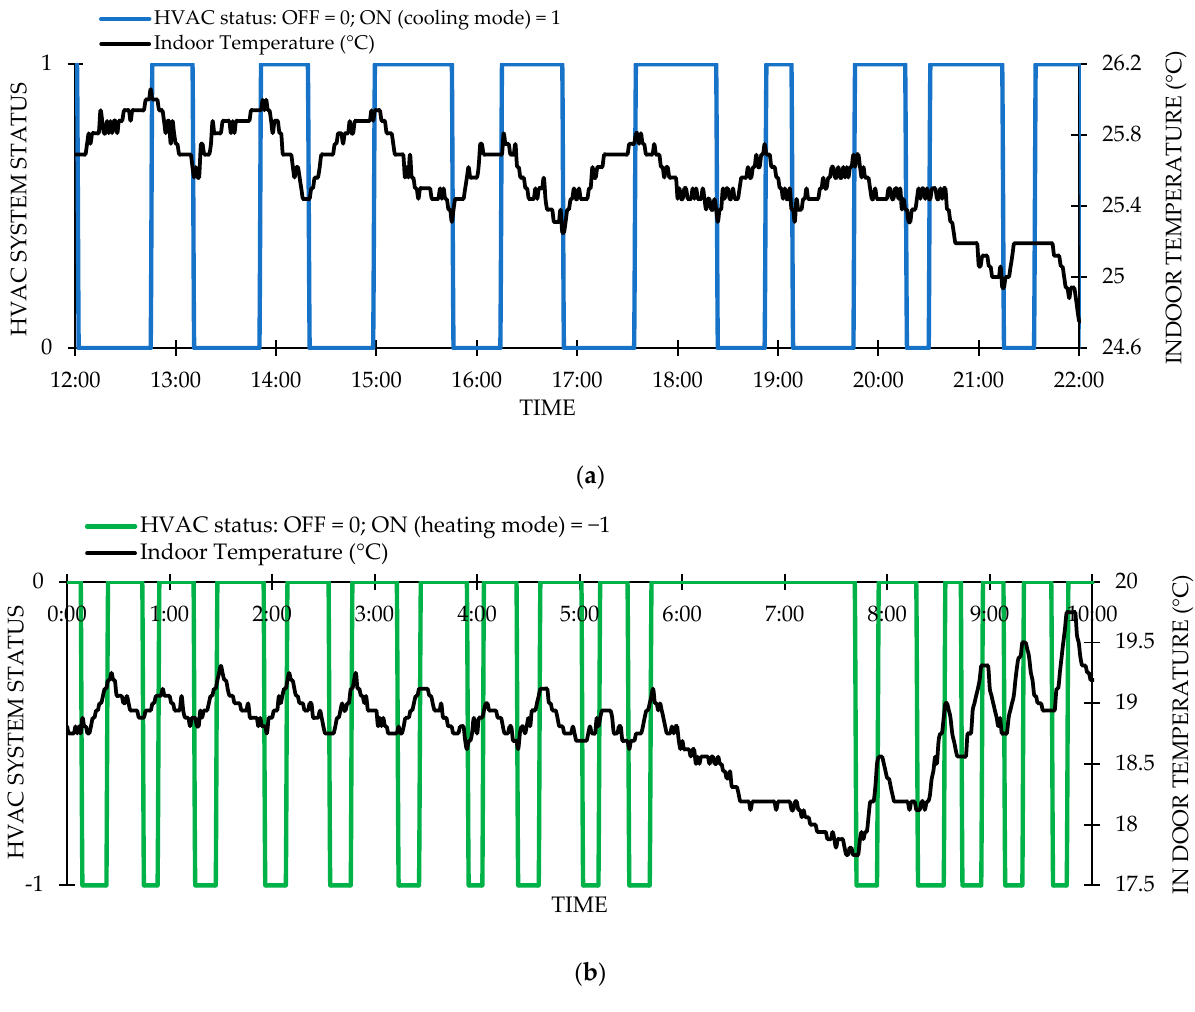
Figure 7. HVAC system on/off status in ( a ) cooling mode and ( b ) heating mode with indoor temperature in a sample residential building.